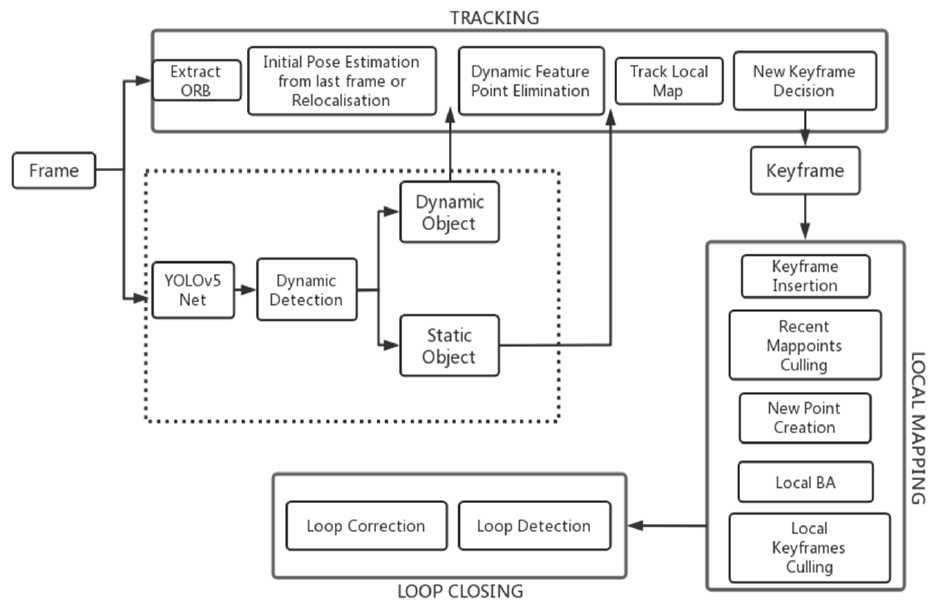
Figure 5. Dynamic object rejection algorithm framework.